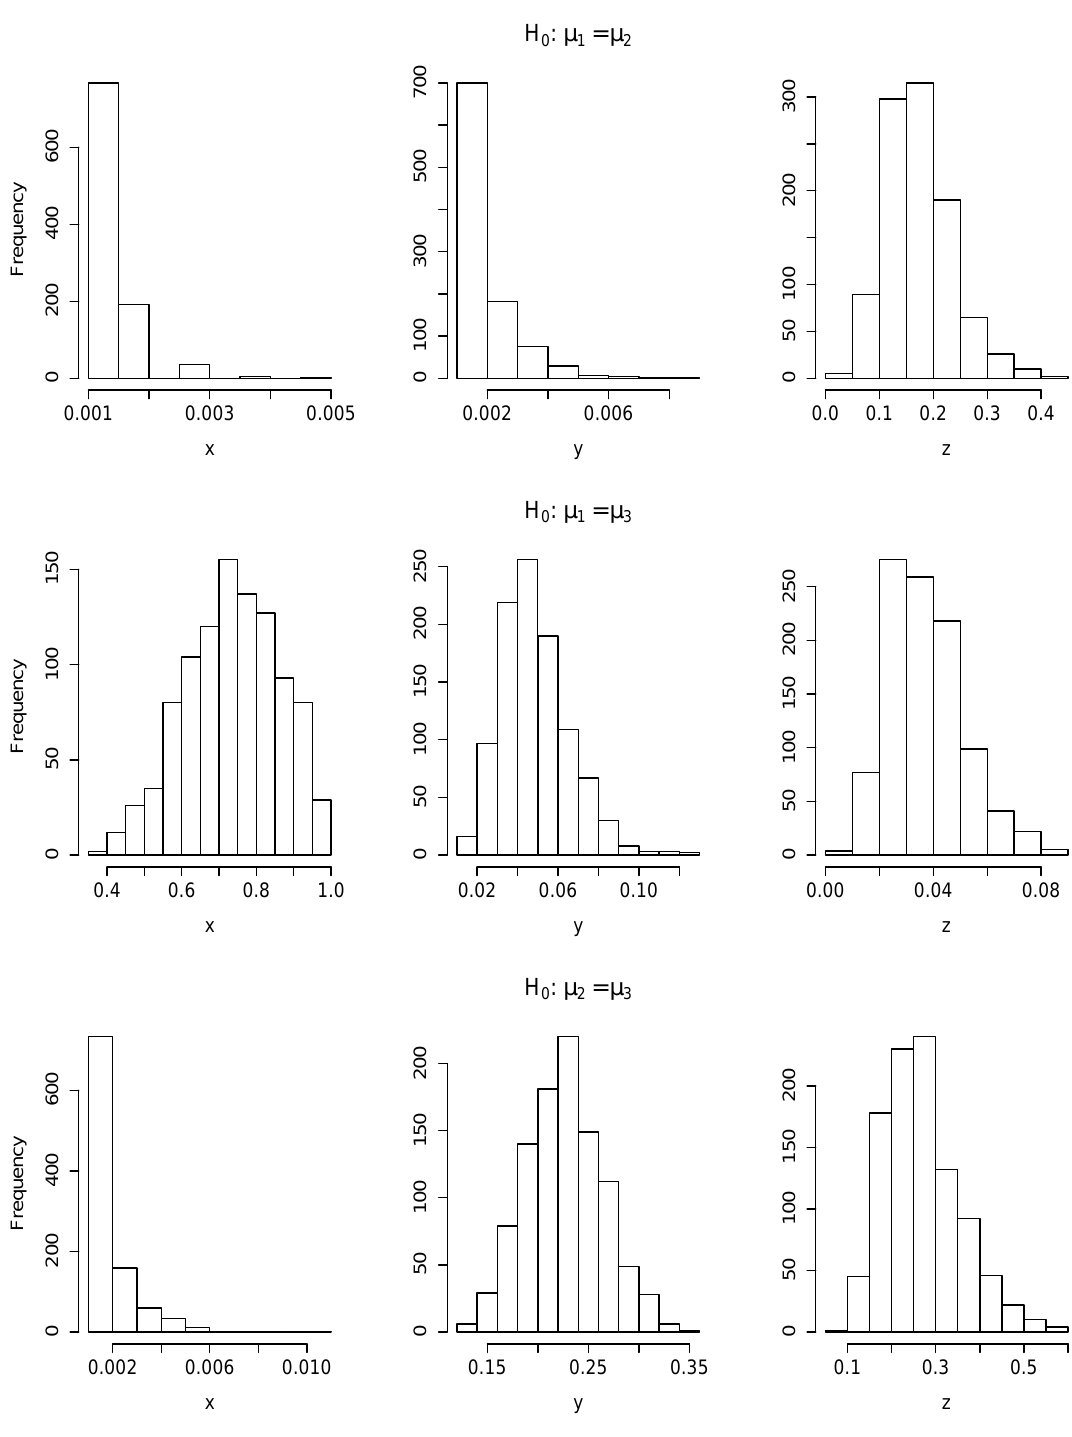
Figure 4. Histograms of 1000 p -values resulting from applying the test of equality of means based on the L 2 norm for the null hypothesis: H 0 : µ 1 = µ 2 ( top row ), H 0 : µ 1 = µ 3 ( middle row ) and H 0 : µ 2 = µ 3 ( bottom row ) on the x -axis ( left column ), y -axis ( middle column ) and z -axis ( right column